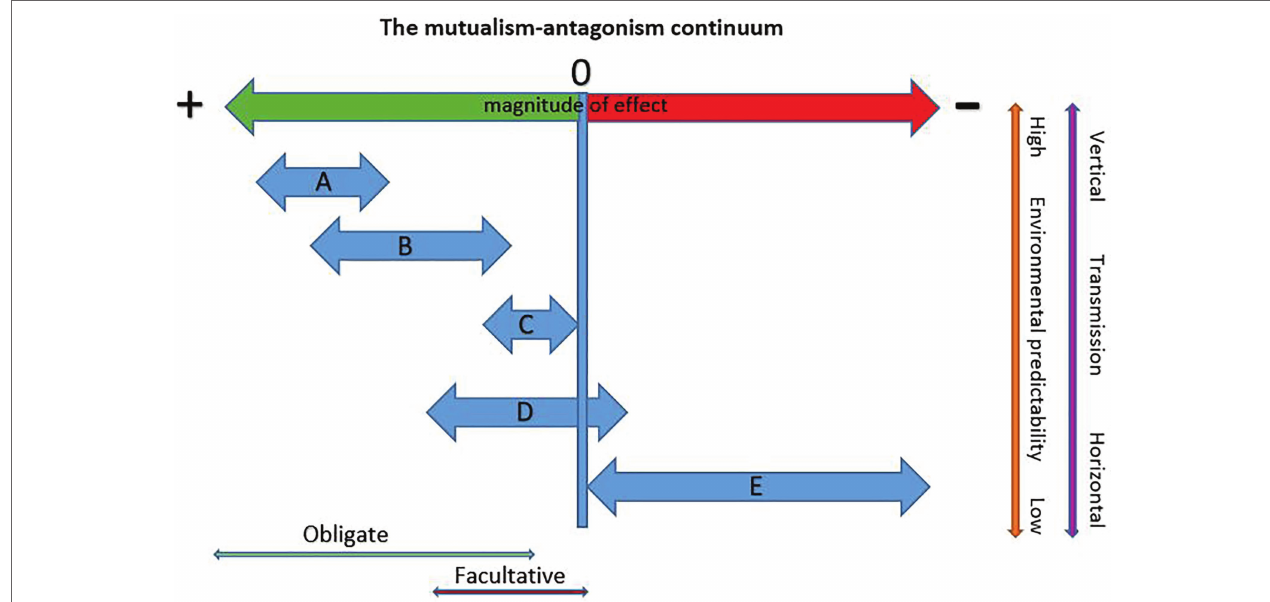
FIGURE 1 | Hypothetical placement of different bark beetle-fungus symbiosis types on the mutualism-antagonism continuum. Potential for context dependency increases with increasing environmental heterogeneity and horizontal transmission. (A) Obligate and specific (beetle and fungus) mutualisms with vertical transmission via complex structures (mycangia). Typified by aggressive primary beetles requiring high quality nutrient provisioning by fungi and that show a high degree of coevolution with partners. Sign shifts do not occur and magnitude of benefit shifts is highly constrained. (B) Obligate (beetle and fungus) mutualisms that may be specific for beetle and fungus or a beneficial fungus may be found with several related hosts. These have mostly vertical transmission via simple transport structures (modified pits or setae) and are typified by secondary bark beetles that require high quality nutrient provisioning by fungi. Co-evolution likely. Sign shifts do not occur but the magnitude of benefits may shift contingent with the quality of benefit delivery and availability of phloem. (C) Obligate (beetle only), low specificity mutualisms wherein secondary bark beetles exploit fungi brought in by other bark beetles or transport the fungi themselves in simple structures (pits and setae). Co-evolution unlikely and beetles do not require high levels of nutrient provisioning. Sign shifts do not occur but the magnitude of benefits may shift. (D) Non-obligate, non-specific interactions involving aggressive or nonaggressive secondary beetles with variable suites of environmentally acquired fungal partners. Because of the unreliable nature of these interactions, the beetle has low-to-no dependence on fungi and primarily gains nutrients from phloem. Shifts in sign possible with some partners. Co-evolution unlikely. (E) Third party fungi that may exert little influence or compete with either the beetle and/or its mutualist fungi or otherwise negatively affect fitness. Sign shifts, if they occur are from commensal to antagonist and the magnitude of effects may shift from negligible to highly antagonistic depending on the third